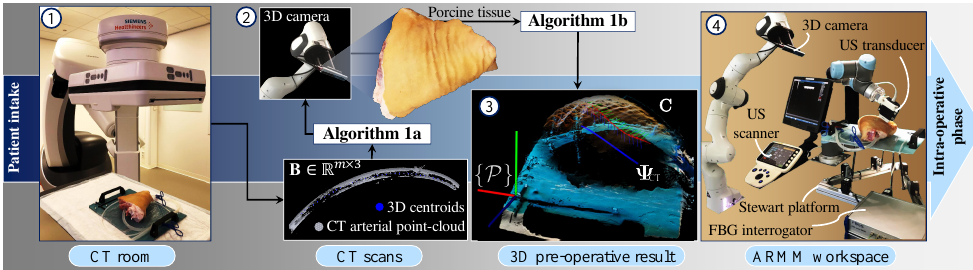
Figure 1. Pre-operative planning for the ultrasound (US) transducer. 1 The porcine tissue is scanned pre-operatively with a computed tomography (CT) scanner. The resulting scanning data are converted to a point-cloud dataset ( B R m × 3 ). 3D datapoints ( m ) are used as input to Algorithm 1, ∈ which calculates a set consisting of n arterial centroids ( Ψ CT R n × 3 ) 2 A second point-cloud ∈ ( C R r × 3 ) is obtained from a 3D surface scan of the tissue and used as input to the Algorithm 2, ∈ the ultrasound pose planner. 3 The output is visualized as a set of poses consisting of projected surface via-points ( Υ R n × 3 ) and orientations ( θ S n × 3 ). 4 Finally, in the Advanced Robotics ∈ ∈ for Magnetic Manipulation (ARMM) workspace, a US sweep can be performed across the tissue, followed by multi-modal feedback of the 3D artery, tissue surface, and the Fiber Bragg Grating (FBG)-embedded catheter in the intra-operative